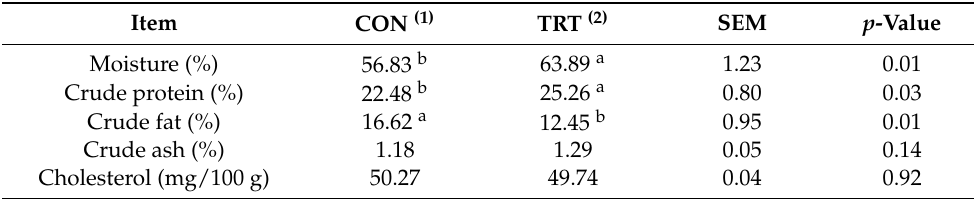
Table 3. Effect of stevioside and organic selenium on proximate analysis and cholesterol contents in the meats of Hanwoo